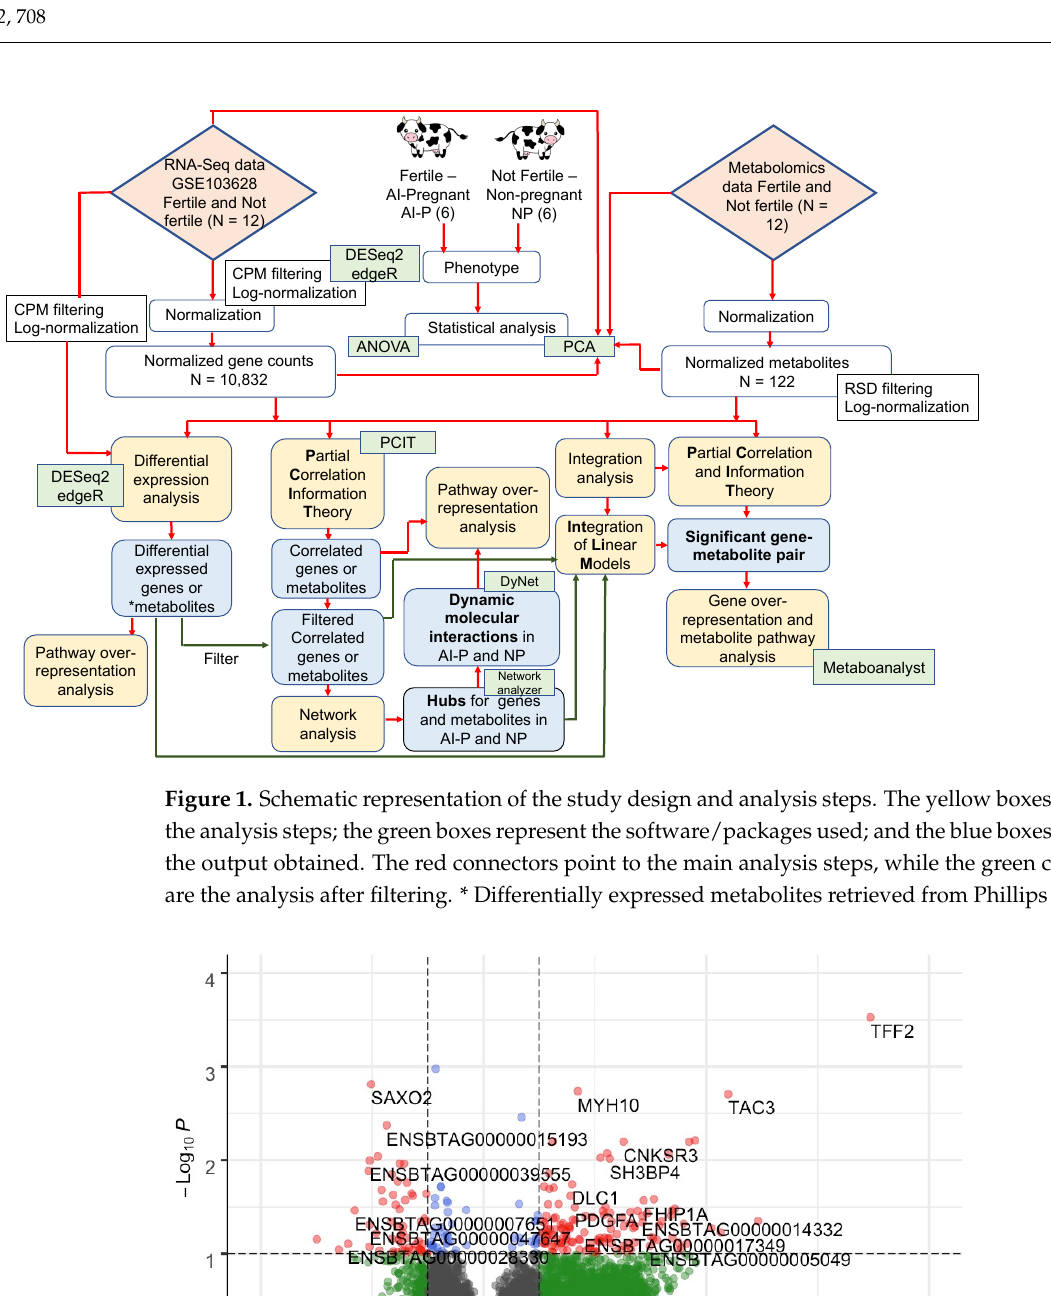
Figure 2. Volcano plot of gene-based differential expression analysis for AI-P ( n = 6) and NP ( n = 6) crossbred heifers. Each dot corresponds to a gene. The x-axis represents log2 fold change for the difference in expression in the AI-P and NP groups. The y-axis corresponds to the negative log (base 10) of the p -value. Grey dots represent nonsignificant genes that did not cross the threshold of p -value or fold-change; green dots represent the genes with absolute (log2 fold change ≥ 0.5); blue dots represent the genes with significant p -value; and red dots represent 38 DEGs ( p -value ≤ 0.05 and absolute (log2 fold change ≥ 0.5)). The genes on the left panel (0 to − 2 of log2 fold change) were downregulated, while the genes on the right panel (0 to 4 of log2 fold change) were upregulated. For the gene network, the correlation of 10,832 genes identified 3,263,960 signifi- cantly correlated gene pairs in the AI-P group, while 5,058,326 significant correlations were identified for the NP group. To reduce data dimensionality and retrieve